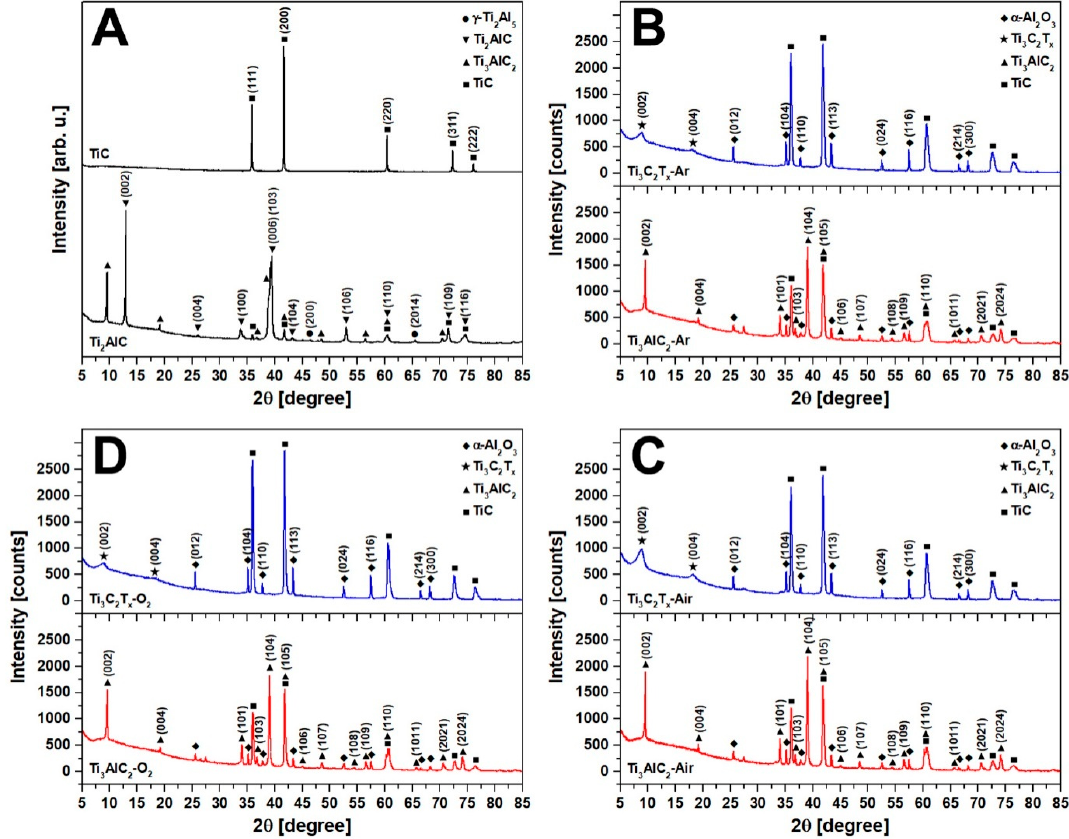
Figure 1. The XRD patterns of ( A ) TiC/Ti 2 AlC powders as well as Ti 3 AlC 2 /Ti 3 C 2 T x obtained by powder mixtures prepared in ( B ) argon, ( C ) air and ( D ) oxygen environments.